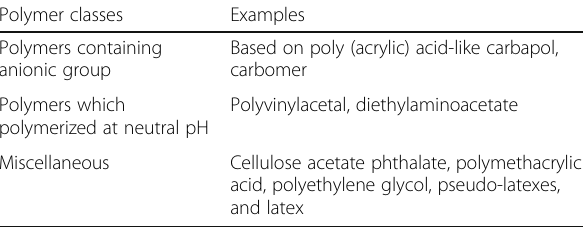
Table 5 Various pH-sensitive polymers [69,